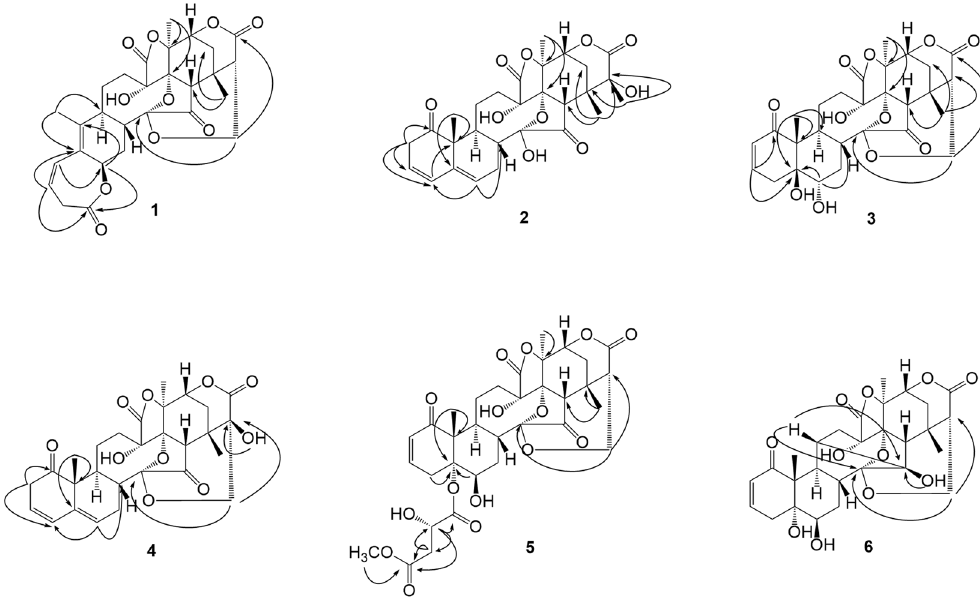
Figure 2. Selected HMBC correlations of compounds 1–6 .